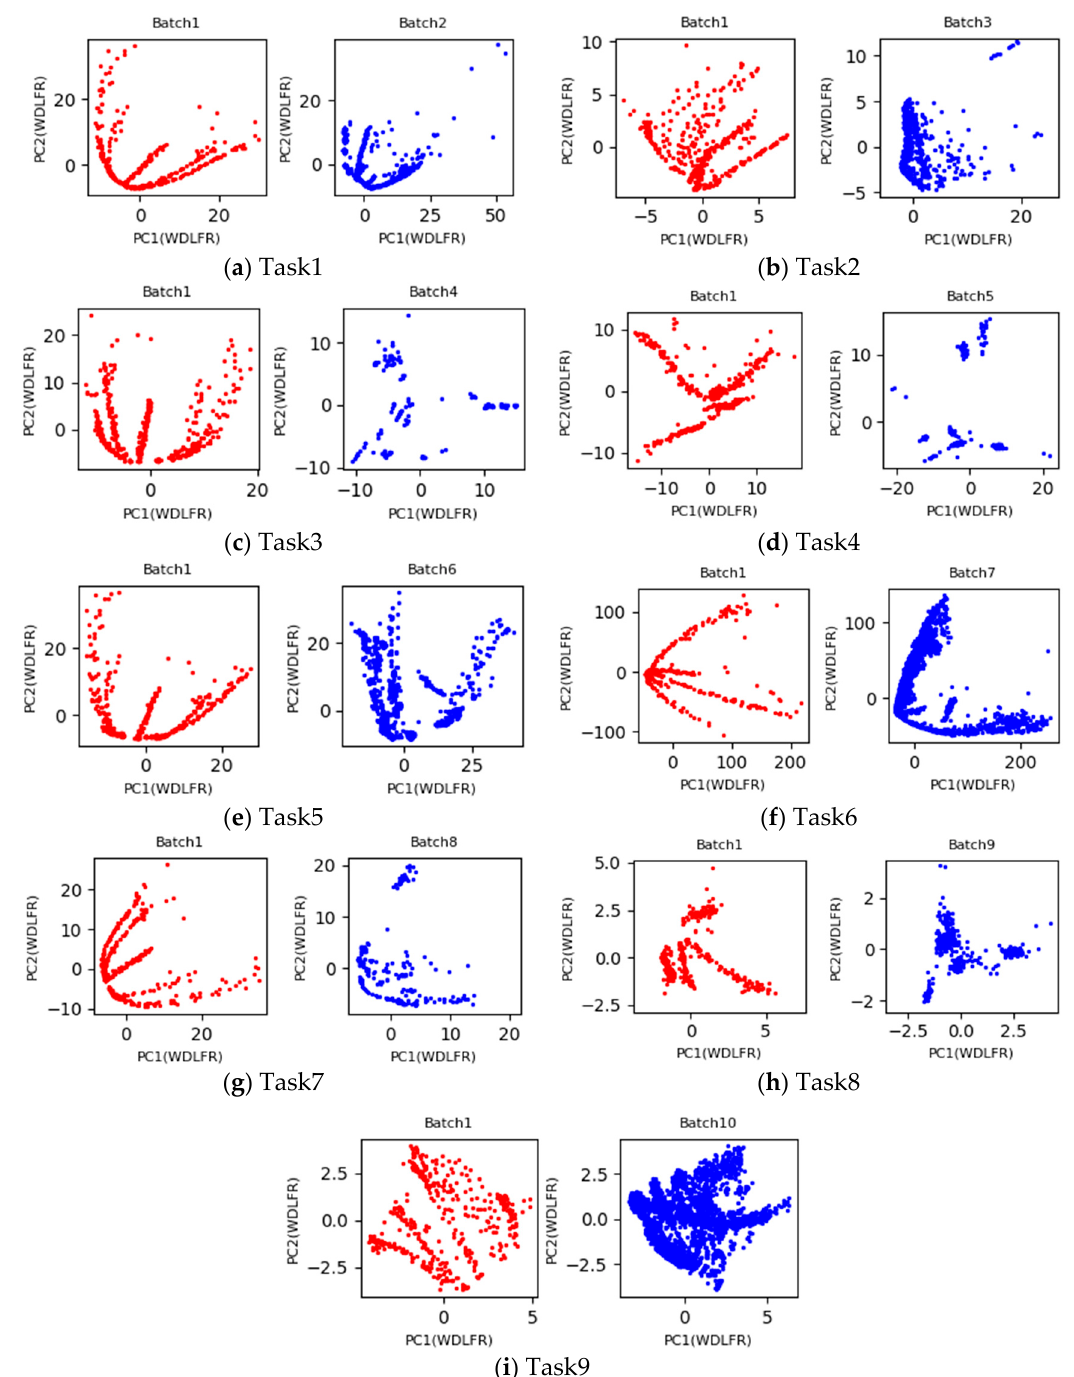
Figure 3. Two-dimensional principle component scatter points of the source and target domain feature representations after using the proposed WDLFR method.